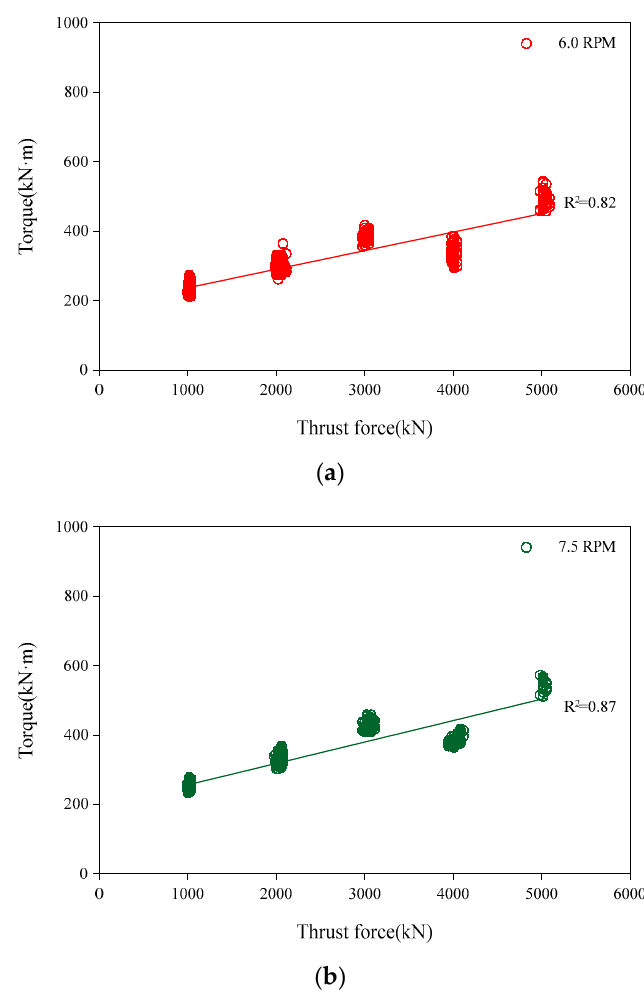
Figure A1. Effect of number of shield jacks being used on the relationships between torque and thrust force, ( a ) increasing rate of torque getting reversed at 4000 kN thrust force using 6.0 RPM; ( b ) Increasing rate of torque getting reversed at 4000 kN thrust force using 7.5 RPM.